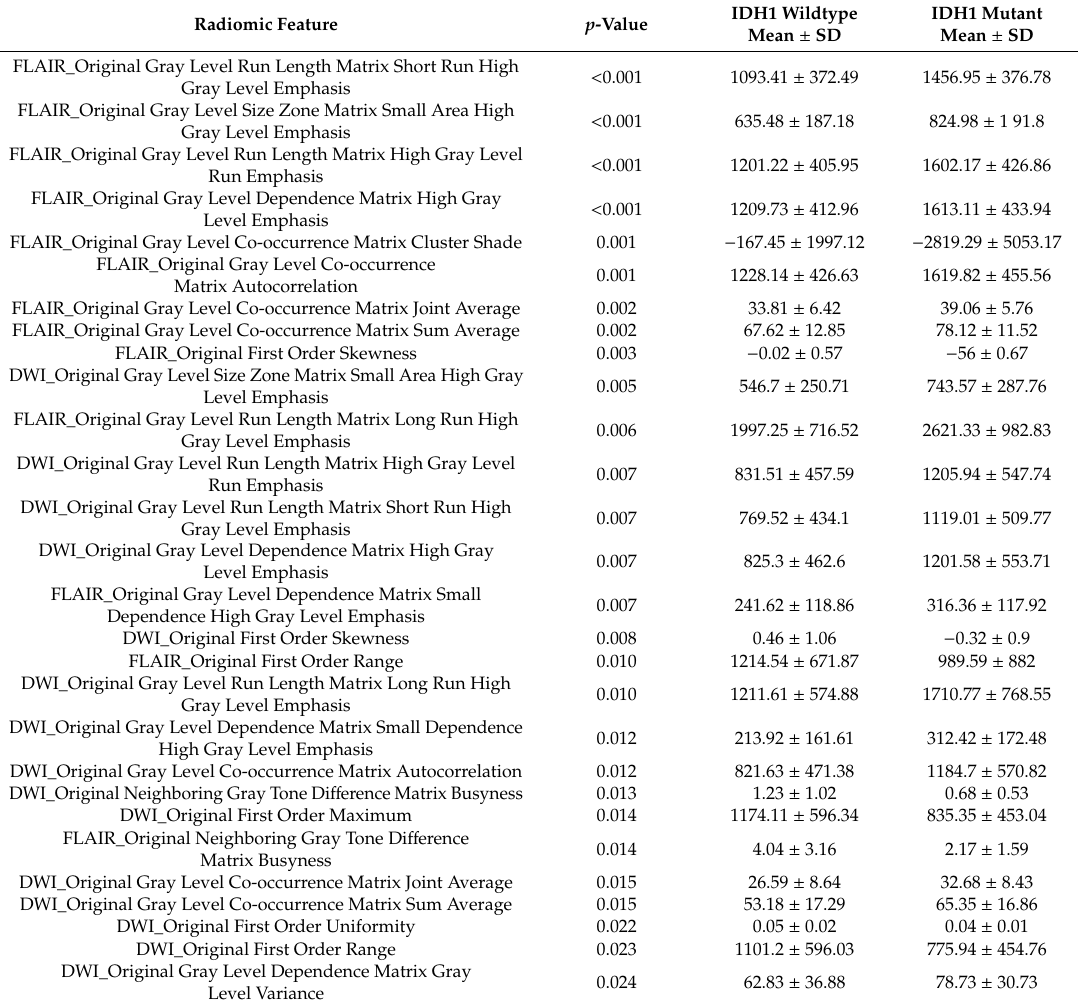
Table A1. DWI and FLAIR radiomic features with significant di ff erence by Wilcoxon rank sum test between IDH1 Wildtype and